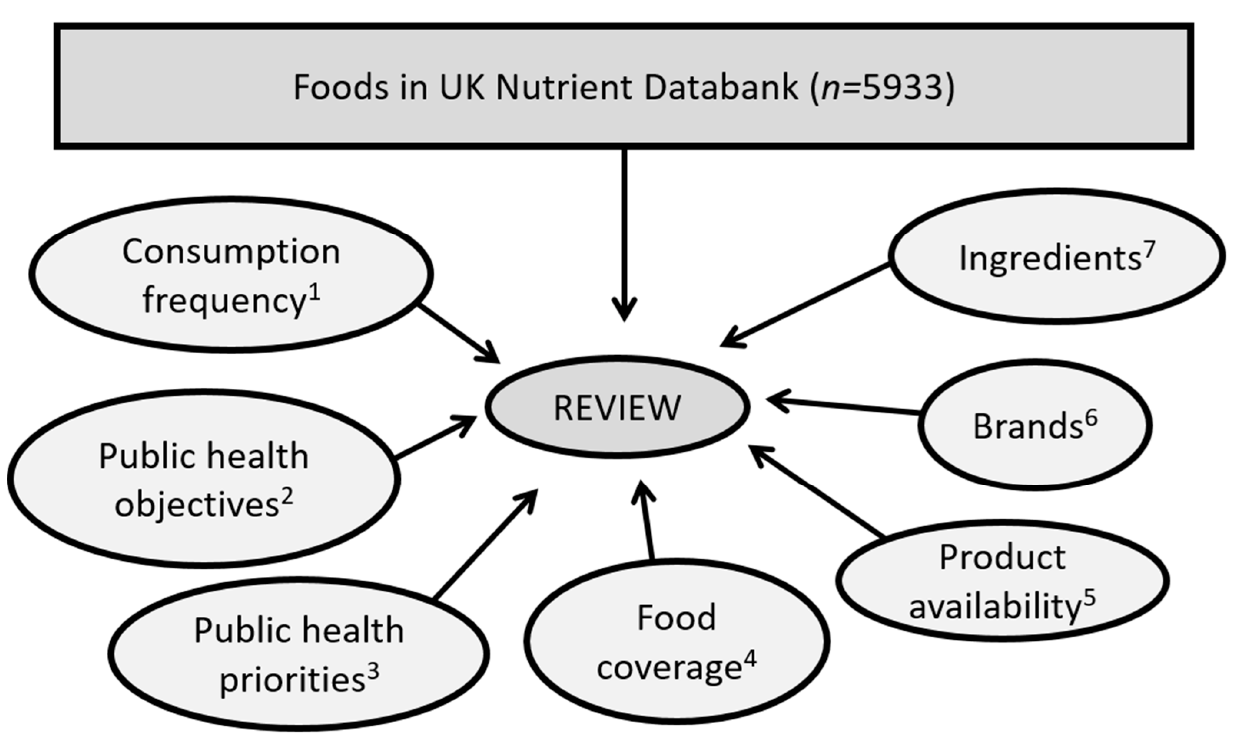
Figure 1. Key factors considered for reviewing foods relevant for inclusion in the rationalised NDB. 1 Dietary intake data from the first 10 years of NDNS RP (2008–2018) were examined to identify reported consumption rates. Foods reported fewer than 10 times (average consumption frequency